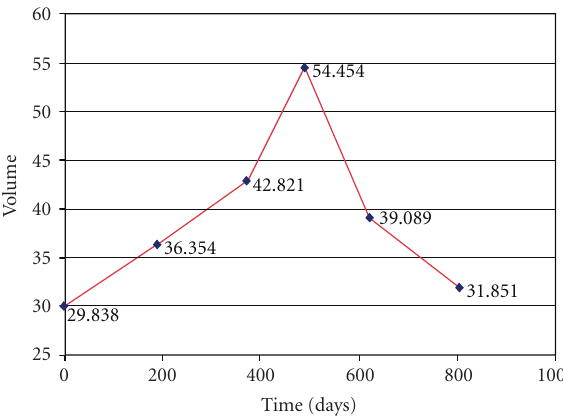
Figure 33: Patient 3. (a) 50 points on the contours, (b) 100 points on the contours, and (c) 200 points on the contours.